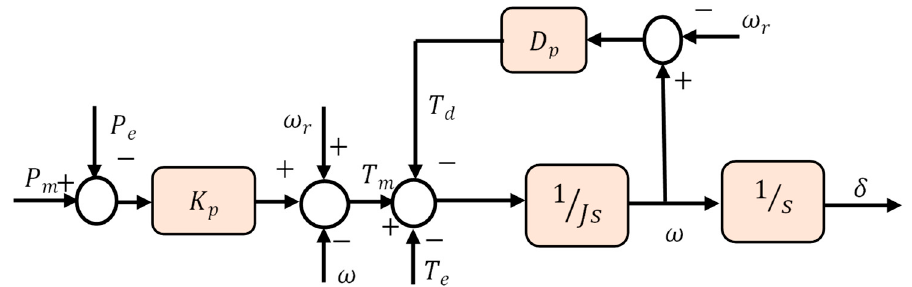
Figure 20. VSG control approach using real and reactive